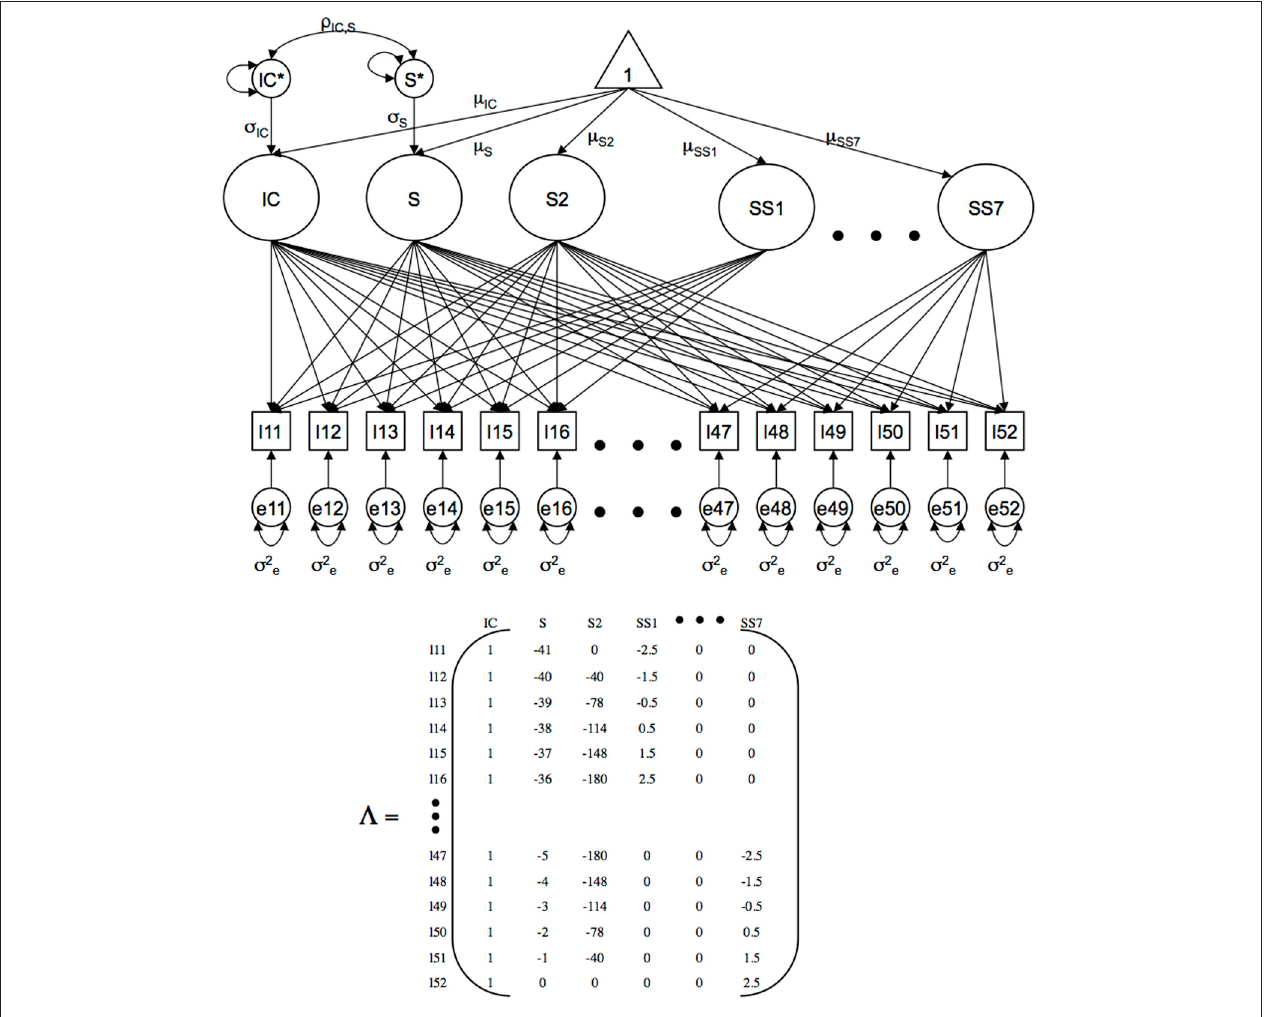
The triangle indicates means. Unlabeled parameters are fixed to the values displayed in the matrix of loadings. IC, intercept, reflecting post-training performance; S, linear slope; S2, quadratic slope; SS1–7, session-wise linear slopes; l,